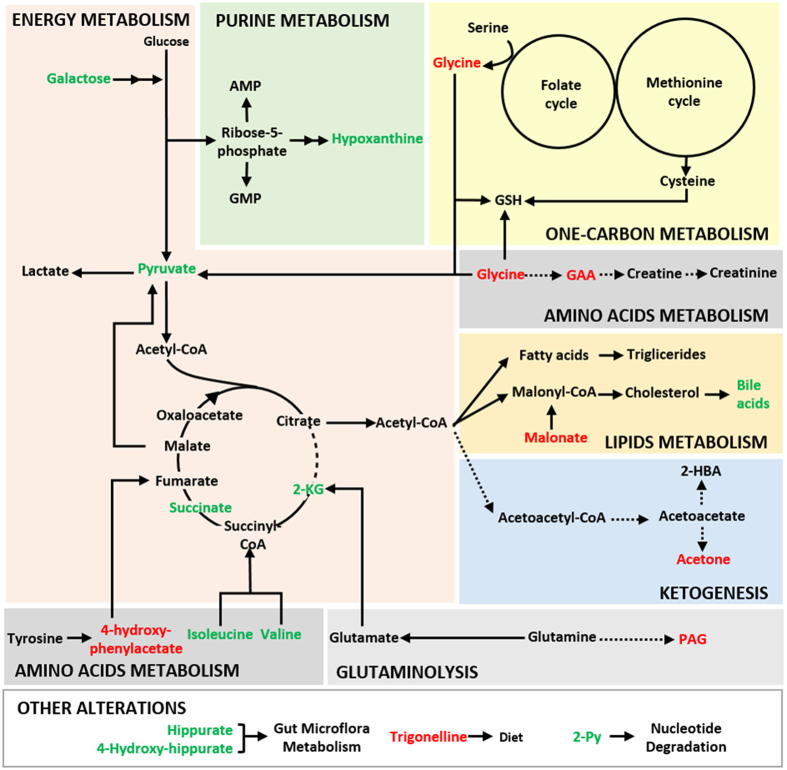
Schematic representation of possibly affected metabolic pathways in RCC.Metabolites found significantly increased and decreased in the urine of RCC patients are presented in green and red, respectively. Metabolic steps hypothesized as up-regulated are presented by bold arrows and those that seem compromised as dashed arrows. 2-HBA: 2-hydroxy-butyrate acid;2-KG: 2-ketoglutarate; 2-Py: N-methyl-2-pyridone-5-carboxamide; AMP:adenosine monophosphate; GAA: guanidinoacetate; GMP: deoxy-guanosine; GSH: gluthatione; PAG:phenylacetylglutamine.